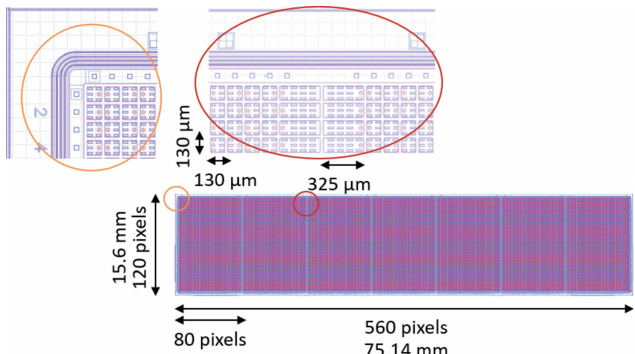
Figure 2 Schematic representation of the XPAD-S70 module. Magnifications of the guard ring and double pixel part are shown (orange and red colours, respectively).